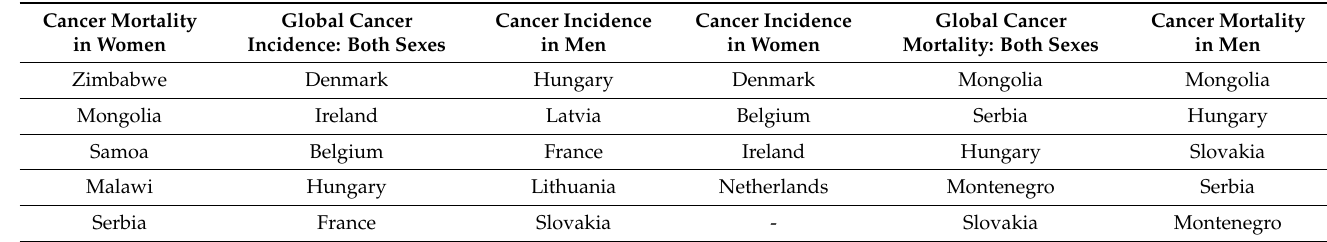
Table 1. List of Global Cancer Data of Top five